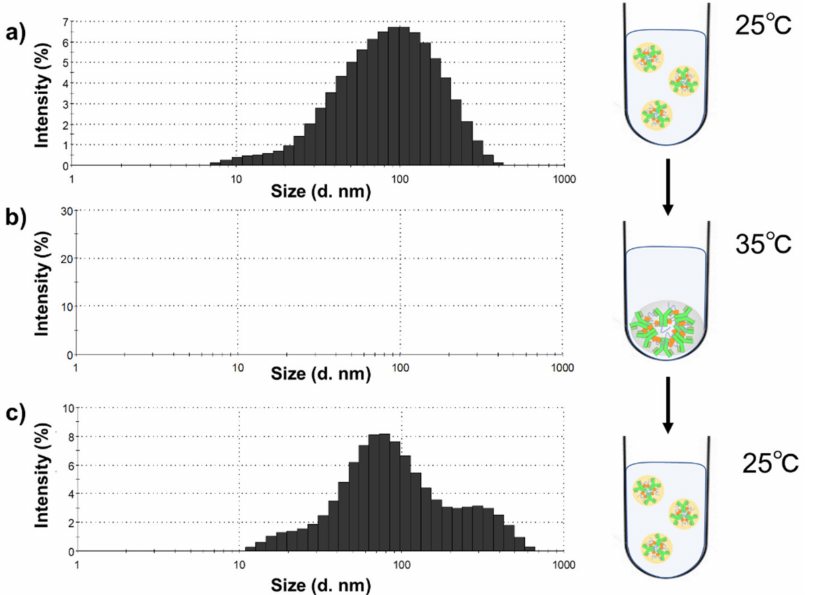
Figure 6. Confirmation of the particle size of IgG–PNIPAAm conjugates in response to temperature using DLS. ( a ) 25 ◦ C, ( b ) 35 ◦ C, ( c ) 25 ◦